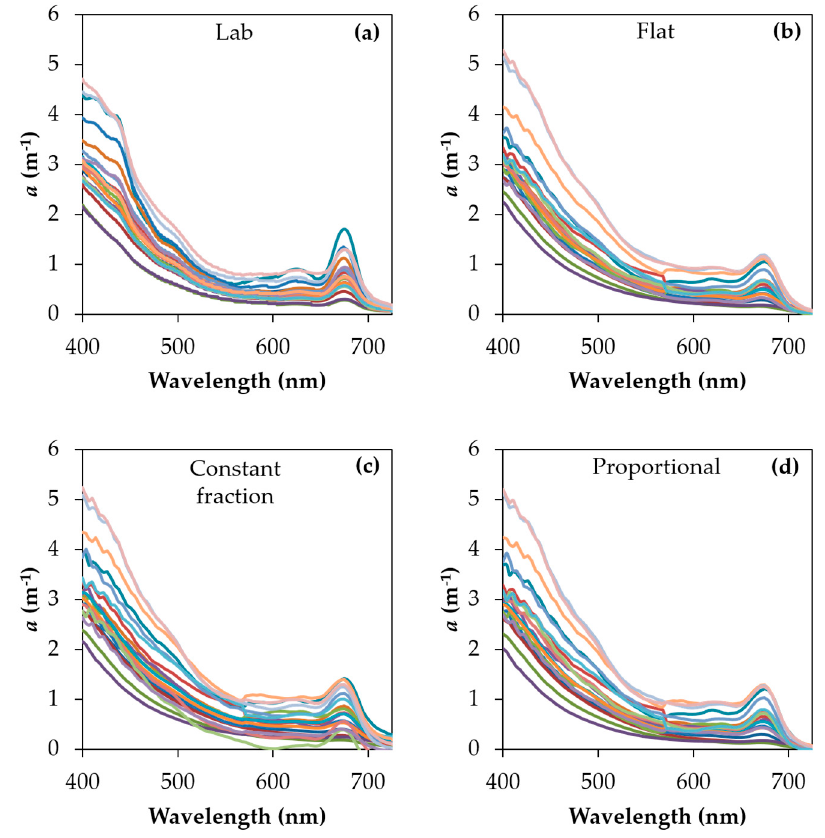
Figure 2. Measurements of a ( λ ) obtained by ( a ) laboratory spectrophotometry and acquired by an absorption and attenuation spectral (ac-s) meter and previously corrected using ( b ) flat, ( c ) constant fraction, and ( d ) proportional methods for the dataset collected in May 2014.